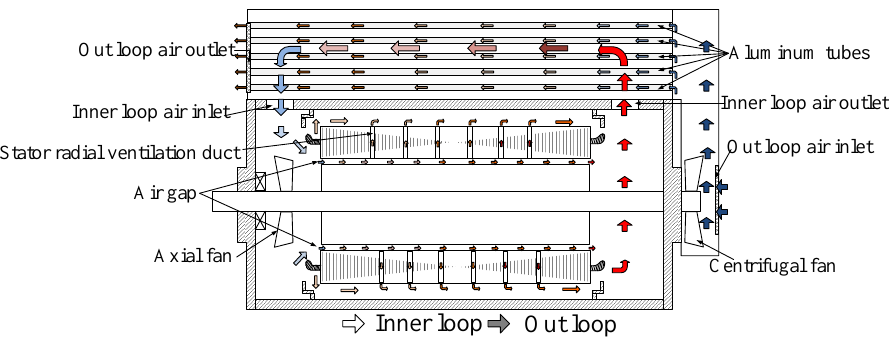
Figure 10. The air-cooled hybrid ventilation systems of HVLSSR-PMSM with dual ventilation path.